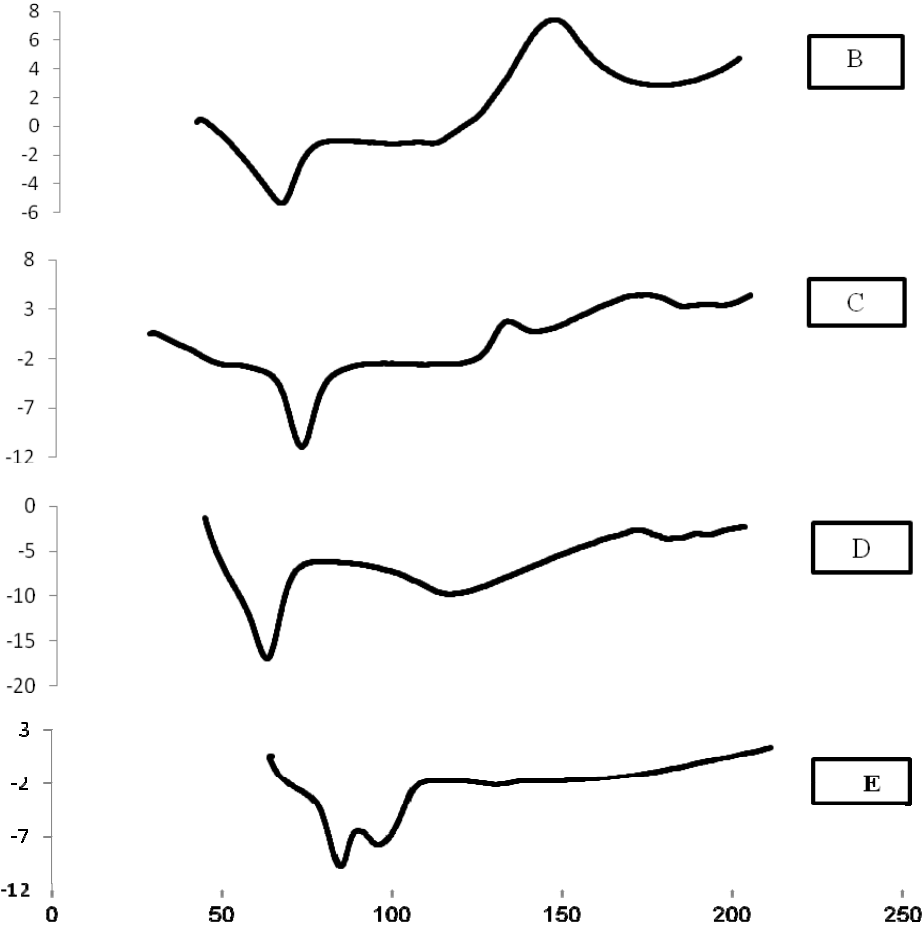
Figure 8. Differential scanning calorimetry (DSC) thermograms of ( A ) pure MIC, ( B ) a physical mixture with Span 80, ( C ) a physical mixture with Tween 80, ( D ) MIC Transfersomes with Span 80, and ( E ) MIC Transfersomes with Tween 80.